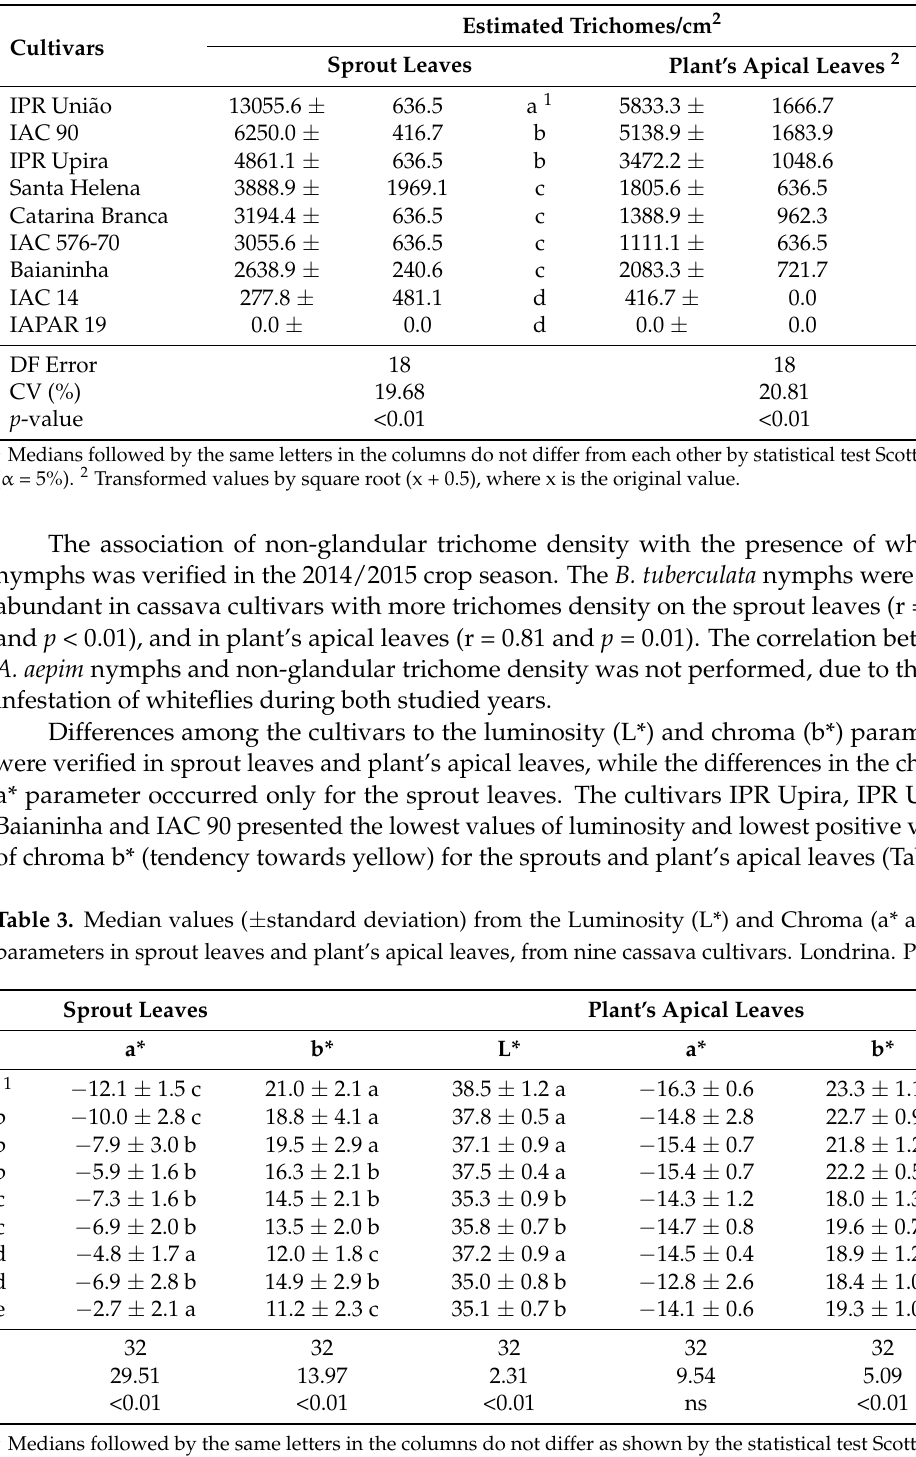
Table 2. Estimated non-glandular trichome density (median ± standard deviation) on sprout leaves and leaves from the plant’s superior third portion, in an area of 1 cm 2 , from nine cassava cultivars. Londrina, Paran á .